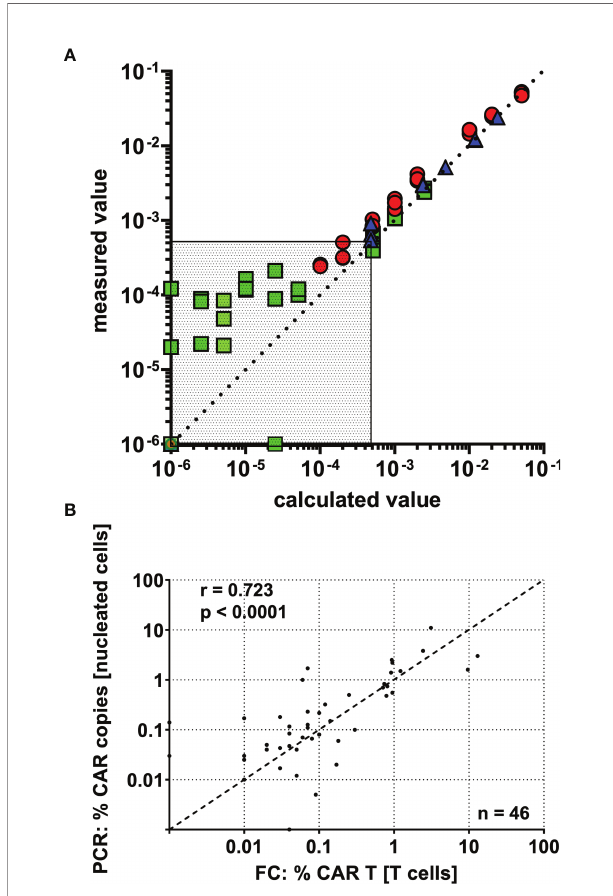
FIGURE 3 | CAR T cell detection shows high precision, linearity, and inter- method agreement down to a lower limit of quanti fi cation (LLOQ) of 0.05% CAR T cells. (A) CAR-T cells were spiked into CAR T cell negative whole blood, and a dilution series was performed. Based on the percentage of CAR T cells in the undiluted spike-in sample, the “ calculated value ” was determined by dividing by the dilution factor and plotted against the “ measured value ” . Data was obtained in three independent experiments (indicated by colors and symbols) with varying amounts of CAR T cells spiked in and different dilution schemes. The region below the assay ’ s LLOQ is displayed as dotted area. (B) 46 post-infusion CAR T cell monitoring samples were concurrently assessed by fl ow cytometry and real-time PCR. The results show clear inter-method concordance by spearman ’ s level CAR T cell persistence during B cell recovery up to 18.6% in three patients (#7, #9, #12). In patient #12, the coexistence of CAR T cells and B cells was repeatedly con fi rmed by real-time PCR testing.